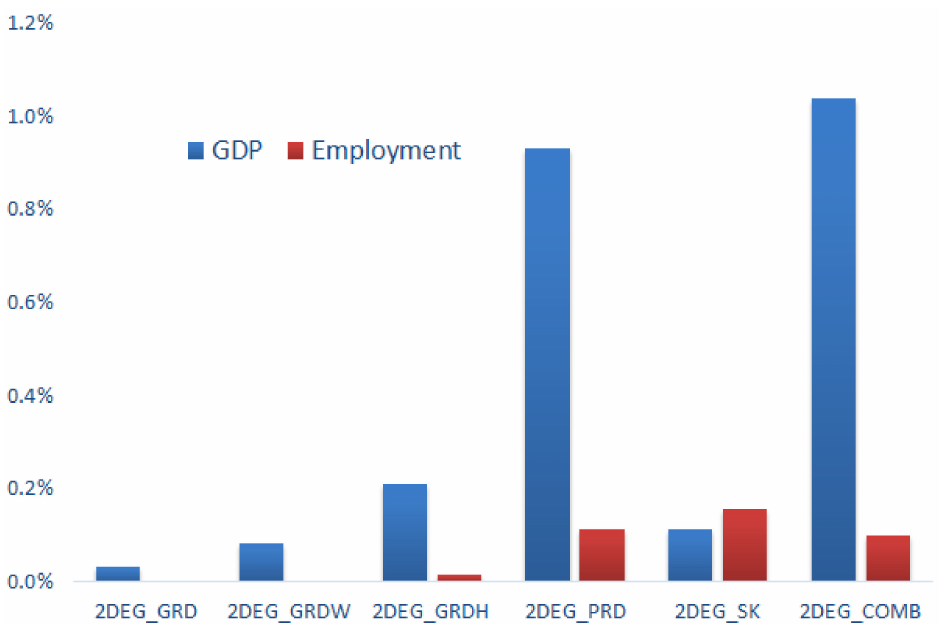
Figure 12. GDP and Employment impacts of policy scenarios (% di ff erence from 2DEG in